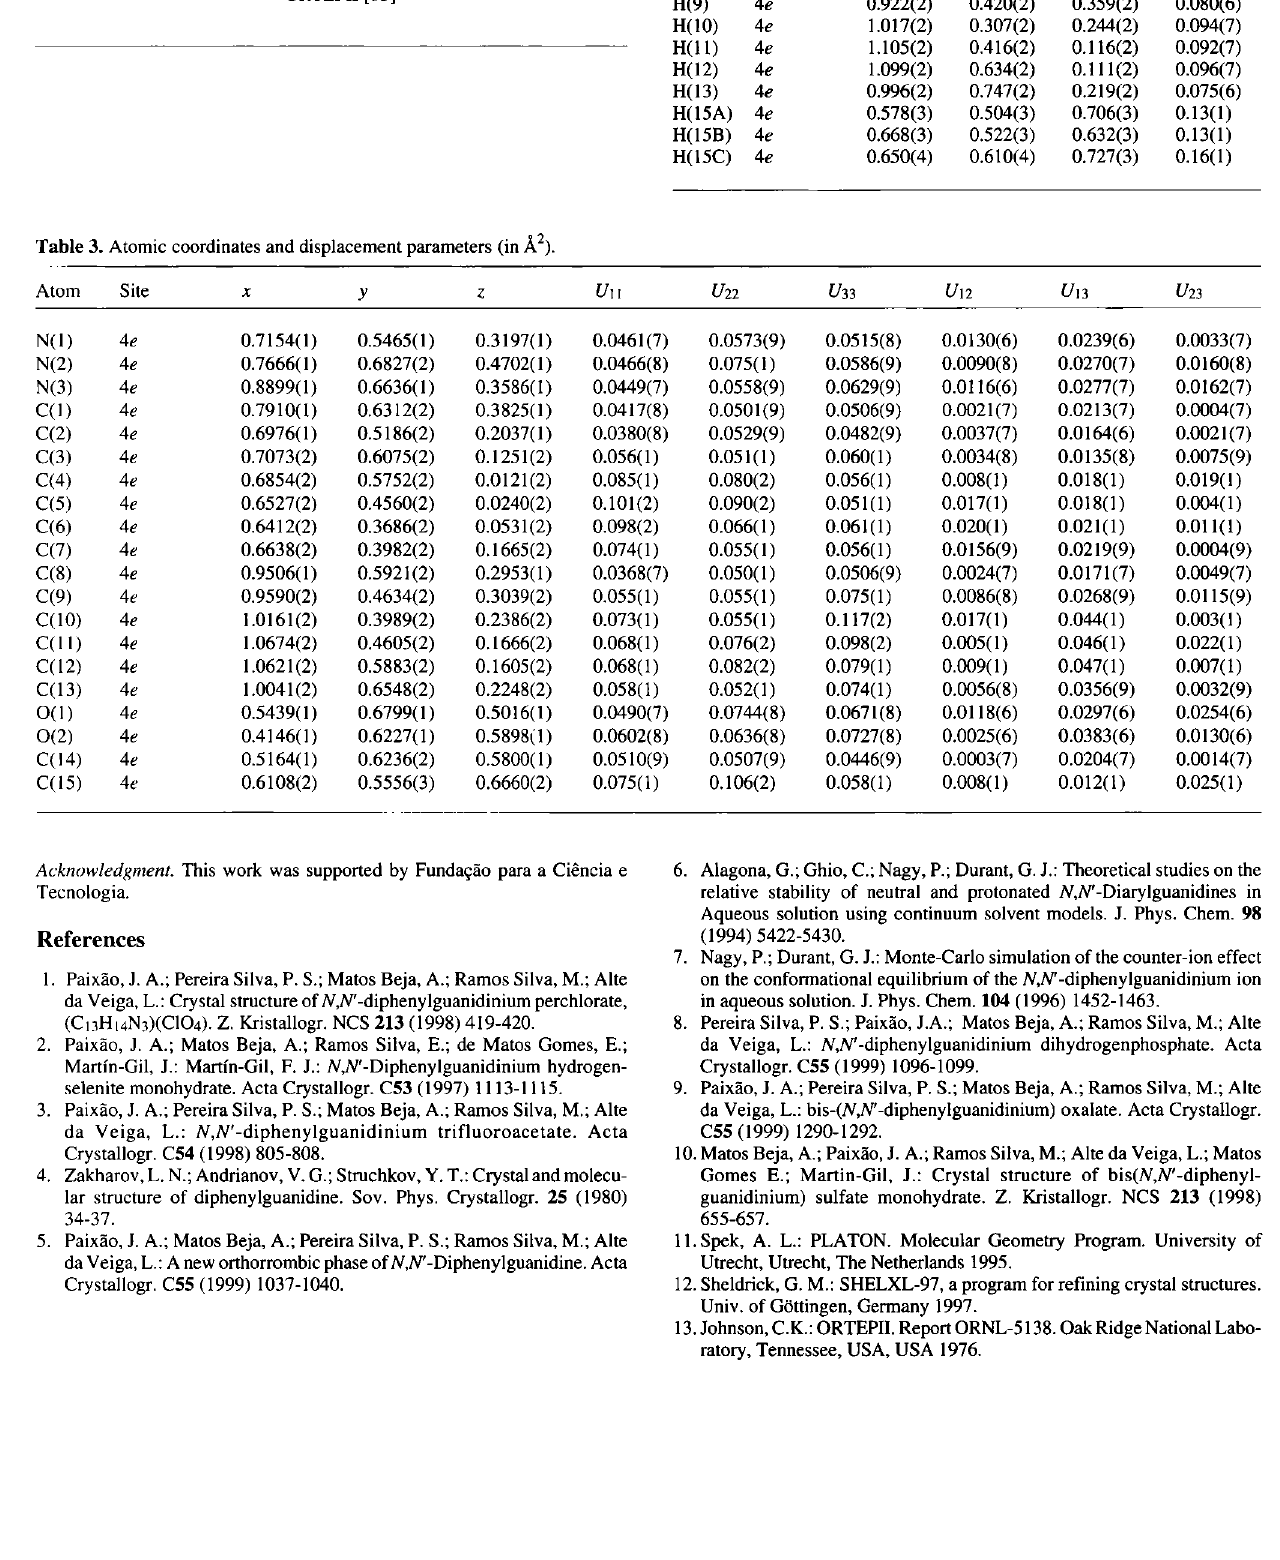
Table 3. Atomic coordinates and displacement parameters (in À 2